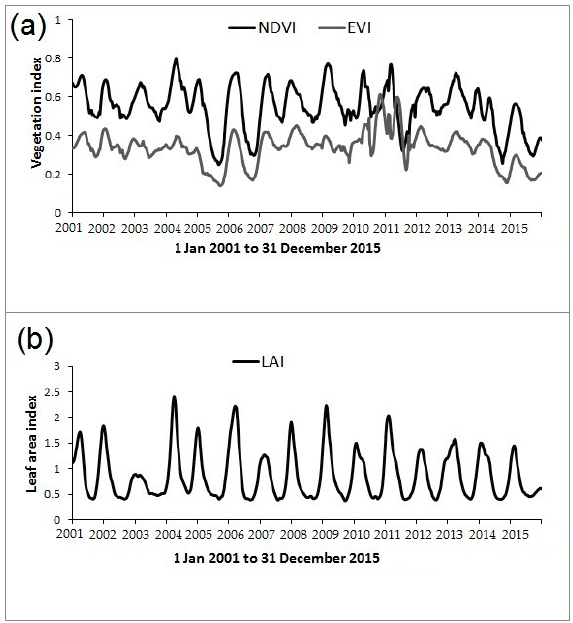
Figure 3. Sample time series of two spectral indices extracted from MODIS imagery of the study area, ( a ) the Normalised Difference Vegetation Index (NDVI) and Enhanced Vegetation Index (EVI), and ( b ) leaf area index (LAI) derived from the red and near-infrared bands.